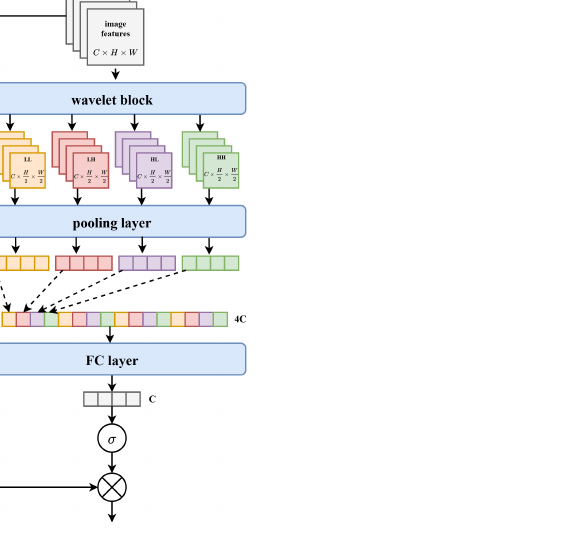
Figure 2. The architecture of the frequency domain demoiré block